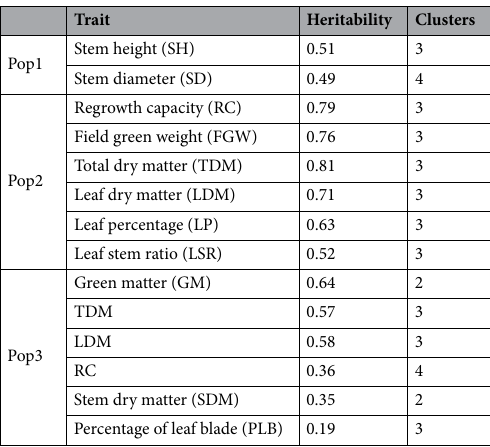
(from 23,637). For all these SNP sets, we observed a significant loss in the number of filtered markers (90% for Pop1, 51% for Pop2, and 78% for Pop3), which was expected due to the large quantity of missing data in GBS experiments and the pseudoreference genomes employed in the SNP calling step. For each of the traits evaluated, we used nine different clustering methods and considered the group configu- ration as that most indicated by clustering indexes calculated with the NbClust package (with the cluster number ranging between 2 and 10). All nine clustering schemes identified for each trait were compared through visual inspections using dendrograms and heatmaps (Supplementary Figs. S7–S9). The most suitable group configu- ration for separating the phenotypic values was assigned for each trait, resulting in different cluster quantities (Table 1). In Pop1, the WardWoSD method was the best clustering strategy. For Pop2, the WardWoSD method was also most appropriate for most of the traits, except for LSR and TDM, which were evaluated using hierarchi- cal complete clustering and the WardWSD approach, respectively. For Pop3, all the traits were evaluated with the WardWSD approach. To provide an overview of the genotypic and phenotypic data, we performed different multivariate analyses. For FG populations, contaminating individuals might be introduced during crosses, which could be detected by such analyses 84 . As expected, we found putative contaminants in Pop2 though t-SNE analysis performed on genotypic data (Supplementary Fig. S10). The individuals with distinct profiles across the Cartesian plane were excluded from the dataset and not considered in further analyses (18 genotypes located apart from most of the population in the t-SNE biplot were discarded). With the final phenotypic datasets, we performed PCAs (Fig. 1), which were used to color and size the t-SNE results from genotypic data. These plots demonstrate the lack of correspondence between the genotypic and phenotypic datasets, corroborating the difficulty of developing predictive models for such associations in the populations under analysis. By considering linear dependency across SNPs and traits, RDAs were performed, allowing the identification of a small number of putative linear associations (233 in Pop1, 37 in Pop2, and 21 in Pop3), evidencing the need for alternative approaches for categorizing the genomic regions linked to the phenotypes analyzed. Single regression genomic prediction. The predictive performance for each trait was evaluated with seven different approaches for the regression task: BRR, RKHS-KA, SM-GK, AdaBoost, KNN, RF, and SVM. By employing 10-fold CV 50 times, we observed superior results for BRR, RKHS-KA, SM-GK and SVM (Supple- mentary Figs. S11–S13, Supplementary Table S1). Although not all four methods ranked best in terms of predic- tive performance for SH (Pop1), RC (Pop2), and PLB (Pop3), there were no pronounced differences between their accuracies and those of the highest ranking models for these traits. For BRR, RKHS-KA, SM-GK and SVM, we also performed LOO evaluations (Table 2). The predictive per- formances were small even in a CV scenario with a larger training dataset. The highest observed R values were 0.38, 0.32 and 0.21 for SH in Pop1 (SM-GK and SVM), LDM in Pop2 (SVM), and SDM in Pop3 (SVM), respec- tively. Additionally, we did not observe clearly superior performance for any model, which would have allowed us to select a specific approach for fitting the regression model. For each trait, one of the four selected methods presented a slightly superior accuracy compared to that of the other three, as already observed in the 10-fold CV evaluations (Supplementary Figs. S11–S13). Even with the best accuracy values observed, SH in Pop1, LDM in Pop2 and SDM in Pop3 could not be efficiently predicted, once again demonstrating the need for the develop- ment of suitable regression methods for complex polyploid grasses.